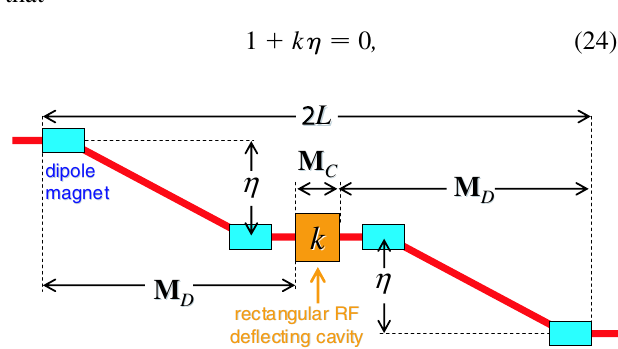
FIG. 2. (Color) Schematic diagram for exact longitudinal-to- transverse emittance exchange, consisting of two identical dog- ) and a transverse cavity ( M legs ( M D M are given by Eqs. (19) and (20), C